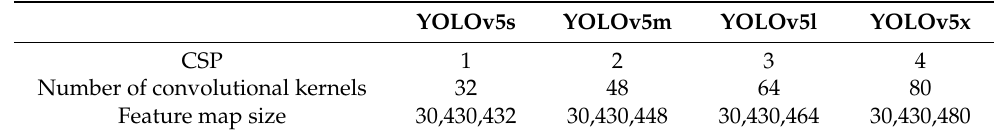
Table 1. Characteristics of four YOLOv5 models.